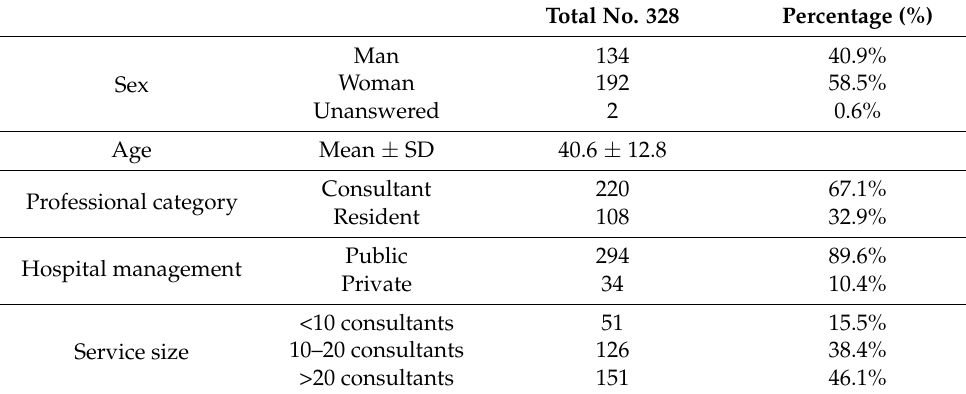
Table 1. Demographic Characteristics.